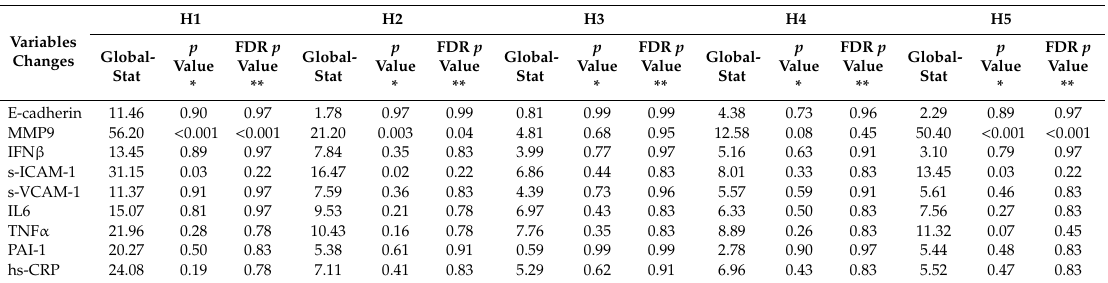
Table 5. Haplotype block analysis of variable changes after vitamin D supplementation (4000 IU / day) for 12